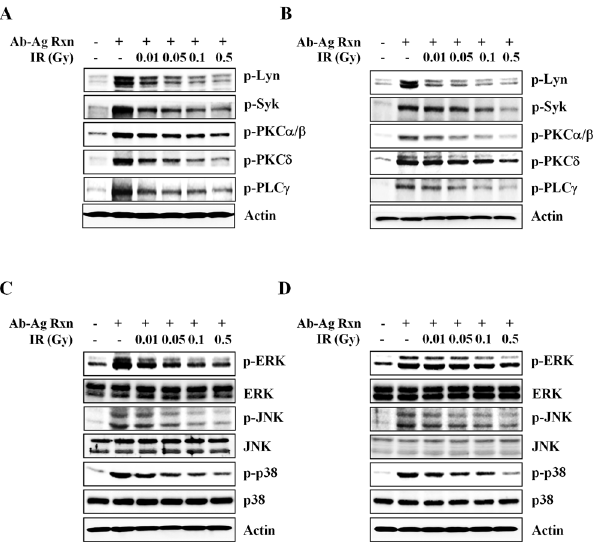
Fig 4. Effects of ionizing radiation on IgE-mediated signal transduction in human mast cells. HMC-1 (5C6) (A and C) and LAD2 (B and D) were incubated for 30 min in medium containing human IgE and then stimulated with anti-IgE. IgE-sensitized HMC-1(5C6) and LAD2 cells were exposed to 0 – 0.5 Gy ionizing radiation and stimulated with anti-IgE. Phosphorylation of signaling molecules was measured with western blotting 5 min (A and B) or 10 min (C and D) after the addition of anti-IgE. Actin was used as an internal standard. Ab-Ag Rxn: antigen-antibody reaction, IR: irradiation.